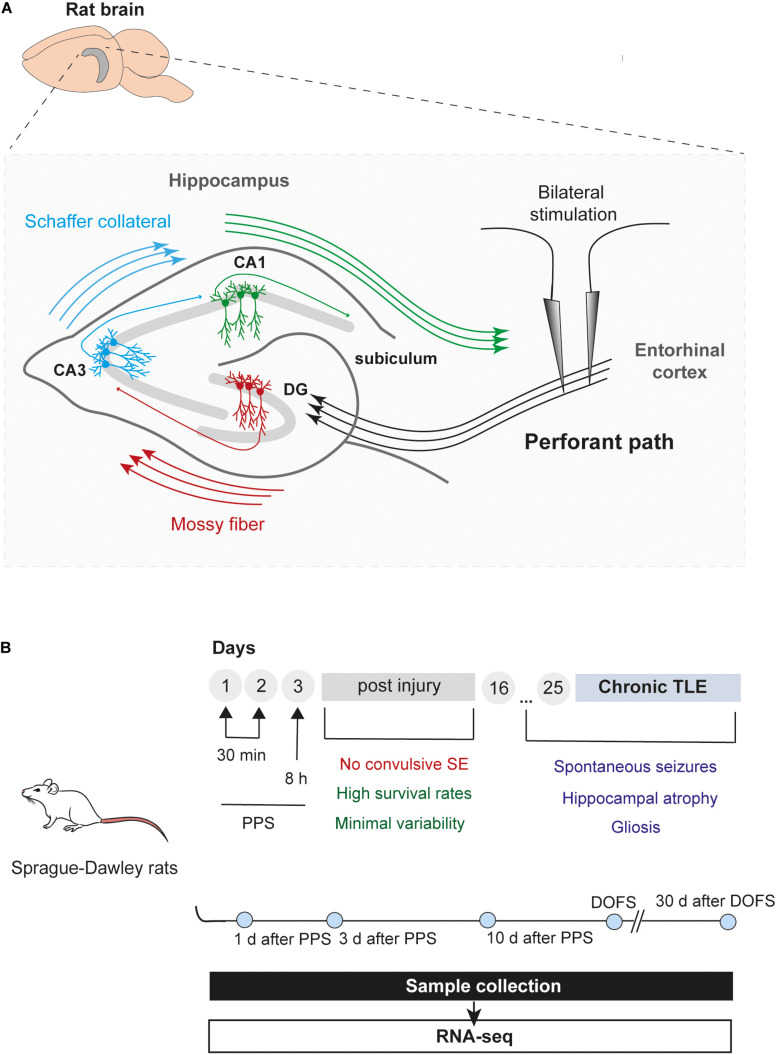
Epilepsy model and timeline of experiments. (A) Schematic illustration of the rat hippocampus showing bilateral stimulation of the perforant path. The perforant path is the major axonal connection between the entorhinal cortex (EC) and all hippocampal areas, including the DG (dentate gyrus), CA (Cornu Ammonis) regions and subiculum (Witter et al., 2000). Briefly, axons from entorhinal cortex (layer II) project toward the DG and CA3 regions, creating a pathway that propagates through the hippocampus back to the EC (EC – DG – CA3 – CA1 – EC). In addition, granule cells from the DG (“mossy fibers”) can project their axons into the CA3 which, in turn, provides input into the CA1 field via a subset of CA3 fibers (“Schaffer collateral”). Finally, CA1 fibers innervate the subiculum, the final target of the pathway, which incorporates all the input information into the output pathway of the hippocampus (Frotscher et al., 1994) (CA1, Cornu Ammonis area 1; CA3, Cornu Ammonis area 3; DG, dentate gyrus). (B) Overview and timeline of the study, including PPS and sample collection. Rats were divided into six groups: 1 day, 3 days, and 10 days after epilepsy induction by PPS (epileptogenesis); on the day of the first spontaneous seizure (DOFS) (early epilepsy); 30 days after the first spontaneous seizure (chronic epilepsy); 17 days after surgery (control group) (TLE, temporal lobe epilepsy; PPS, perforant pathway stimulation; SE, status epilepticus; CA1, Cornu Ammonis area 1; CA3, Cornu Ammonis area 3; DOFS, day of first spontaneous seizure).